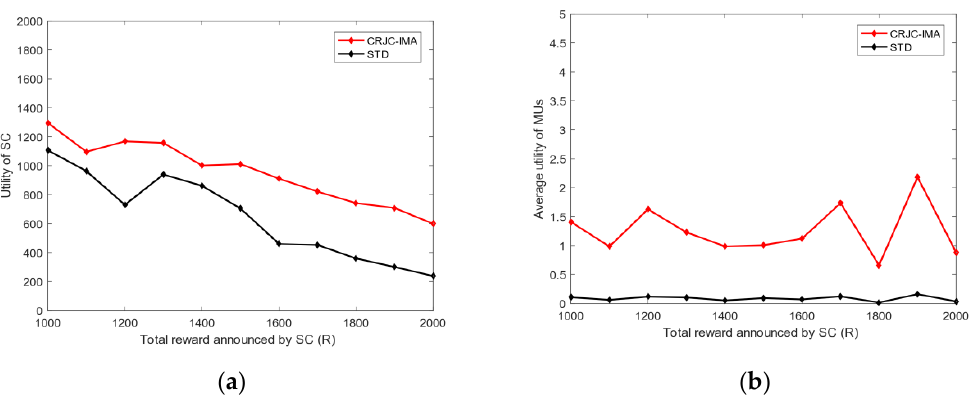
Figure 10. ( a ) Utility of the SC changes with R ; ( b ) average utility of MUs changes with R .